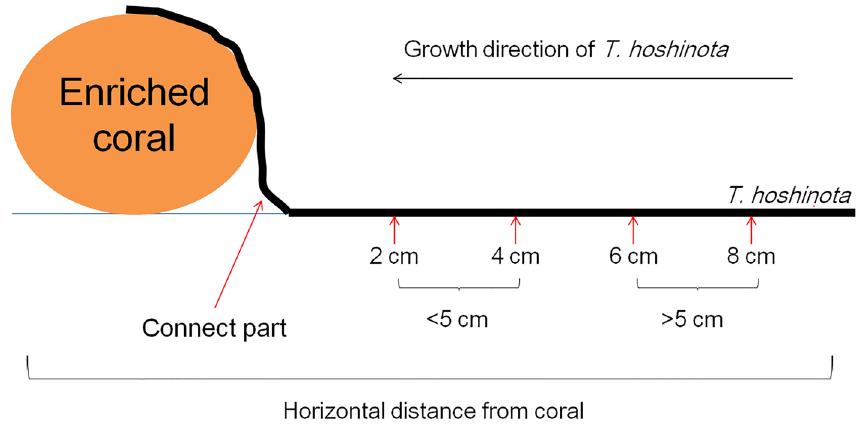
Figure 11. Sponge sampling positions in the nutrient transport